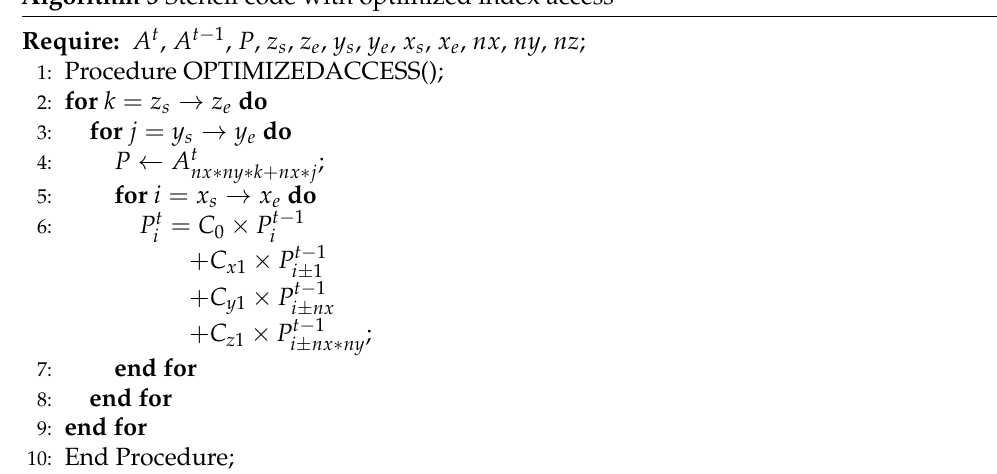
Algorithm 5 Stencil code with optimized index